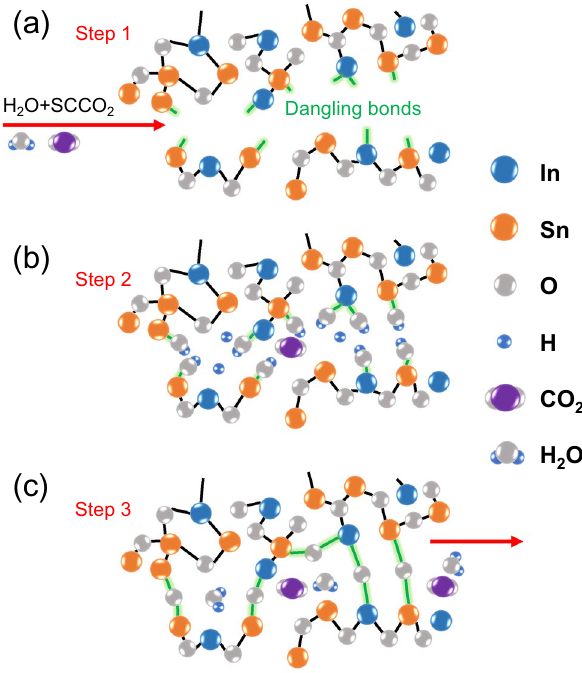
Figure 4. The SCF oxidation reaction processes. ( a ) The H 2 O dissolved in SCCO 2 ; ( b ) The lattice- H 2 O interactions; ( c ) The dihydroxylation process and the occupation of oxygen vacancy.